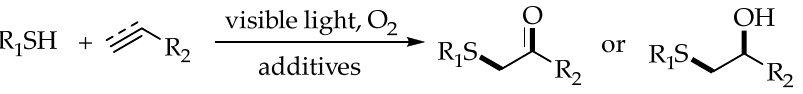
Scheme 14. General strategy for synthesis of β ‐ hydroxysulfides/ β ‐ ketone sulfides.